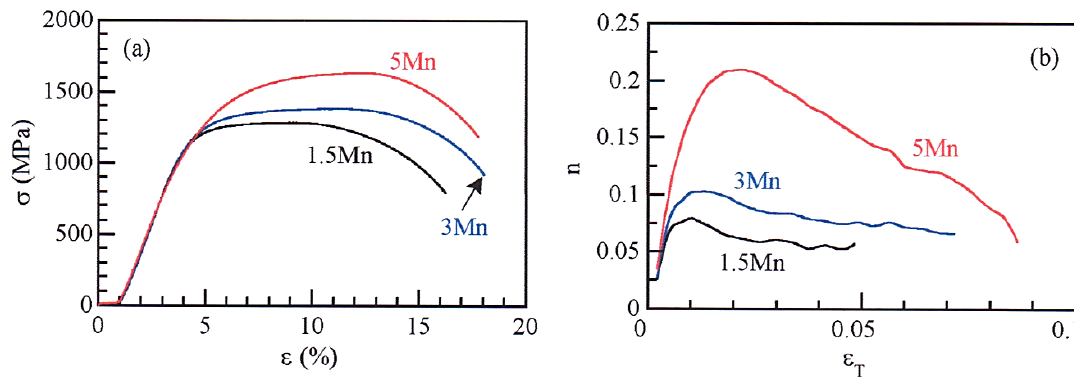
Figure 5. ( a ) Typical engineering stress–strain ( σ - ε ) curves and ( b ) instantaneous strain hardening exponent-true strain ( n - ε T ) curves of the 1.5Mn, 3Mn, and 5Mn steels subjected to the IT process at T IT = 370 ◦ C, 280 ◦ C, and 180 ◦ C, respectively. The IT temperatures are corresponding to M f + (30 ◦ C to 70 ◦ C).